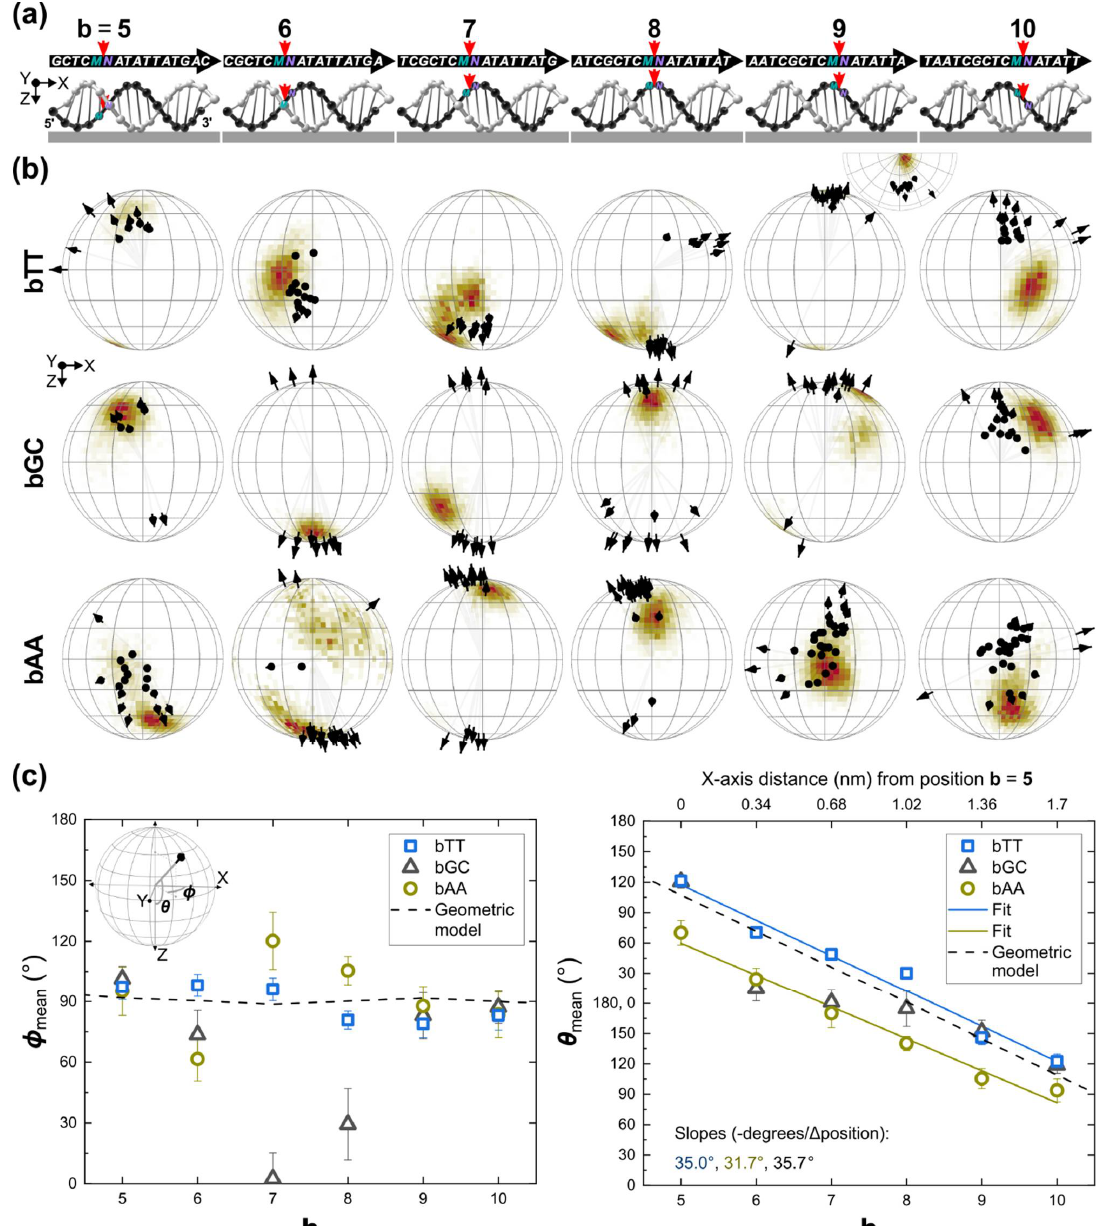
Figure 2. The effect of the neighboring bases on the spatial orientation of Cy5, as a function of the attachment position b . ( a ) Schematics of DNA duplex on the glass substrate indicating b locations used in the study. DNA sequences are shown on top. Samples are labeled as bMN , where M and N were the dye’s flanking bases at the 5′ and 3′ ends, respectively. The 5′-to-3′ direction of the Cy5-tethered strand runs along the positive X-axis (see Figure 1a). ( b ) Results for bTT (top row), bGC (middle row) and bAA (bottom row). Each column of spheres corresponds to the schematics in ( a ). Experimental orientations are plotted on the unit hemisphere as black arrows. MD simulation results are plotted as histograms on the surface of the hemisphere. ( c ) Plots of ϕ mean vs b and θ mean vs b . The inset on the left shows again the coordinates for convenience. A geometric model (dash lines) was constructed based on the neighboring base pairs in a static DNA duplex (see Text S4.1). Error bars are (cid:2026) = ± (cid:3493) (cid:2026) (cid:3051)∗ (cid:2026) (cid:3052)∗ , where (cid:2026) (cid:3051)∗ and (cid:2026) (cid:3052)∗ are the standard deviations of the elliptical cone with the center in the mean direction in the framework of the Kent (Fisher-Bingham) distribution [59].